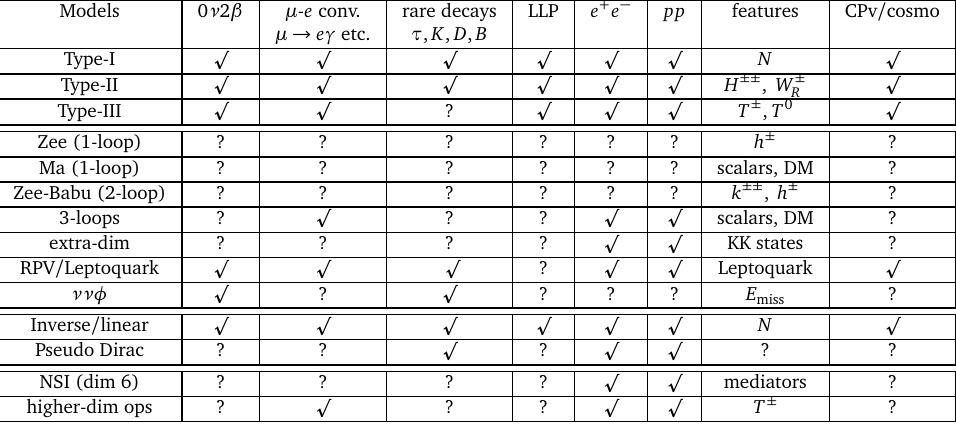
(cid:112) means already